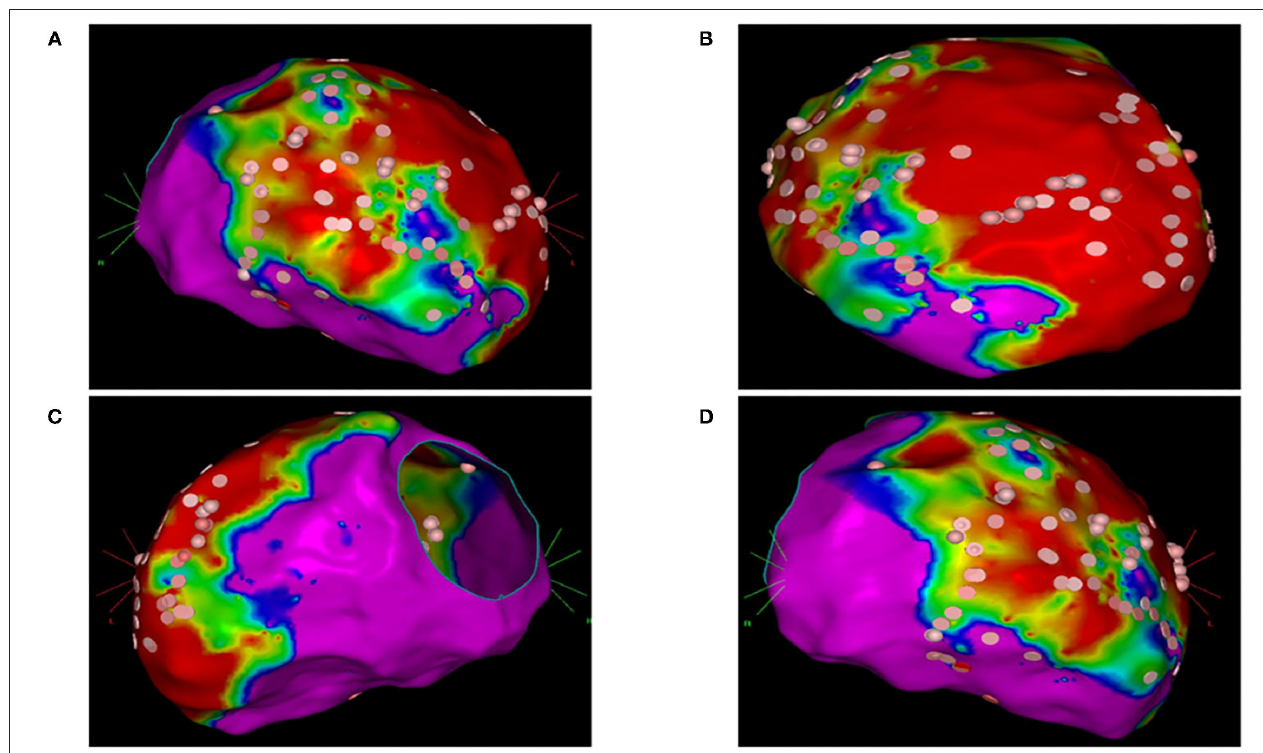
FIGURE 1 | Electroanatomic mapping and ablation of the left ventricle using the CARTO system. (A) Anterior-posterior view. (B) Left anterior oblique view. (C) Left lateral view. (D) Right anterior oblique view. Areas with normal voltage ( > 1.5mV) are represented with purple color. Areas with low voltage ( > 0.5mV) are represented with red color. Border zone areas are represented with blue and green colors (between 0.5 and 1.5mV). Pink tags represent areas exposed to radiofrequency